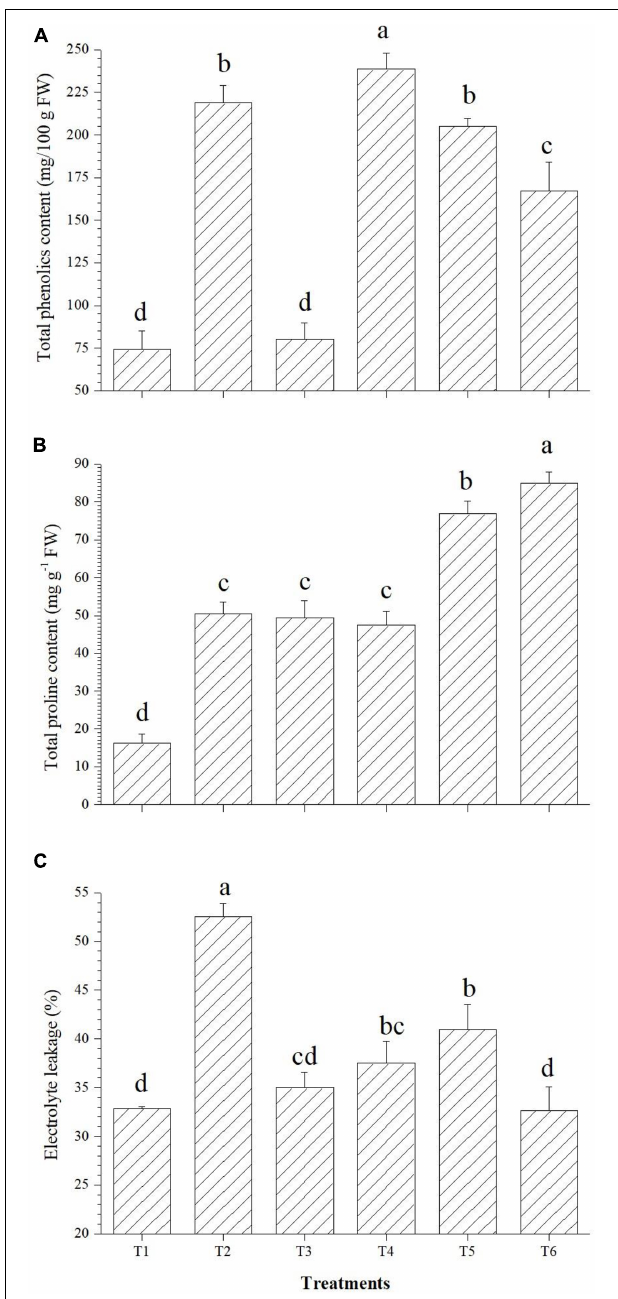
FIGURE 3 | Effect of bacterial endophytes on (A) total phenolics content, (B) proline content, and (C) electrolyte leakage. T1, absolute control; T2, saline control; T3, BTL5; T4, GTR8; T5, GTR11; and T6,